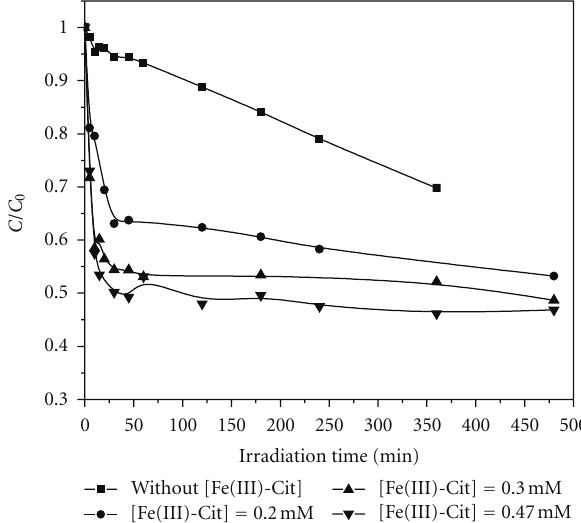
0 Figure 9: m-cresol disappearance in the mixture upon irradiation (365nm) at di ff erent pH: (cid:5) pH = 6.44, (cid:5) pH = 3.50, (cid:6) pH = 2.86.